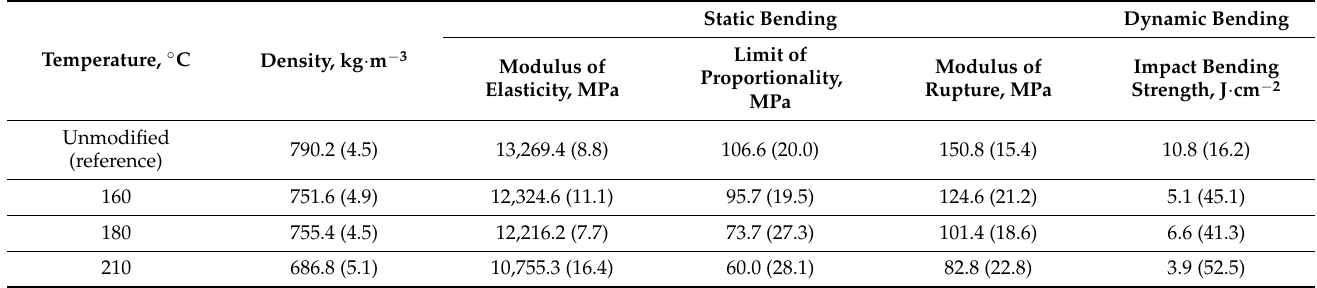
Table 1. Changes of selected static and dynamic